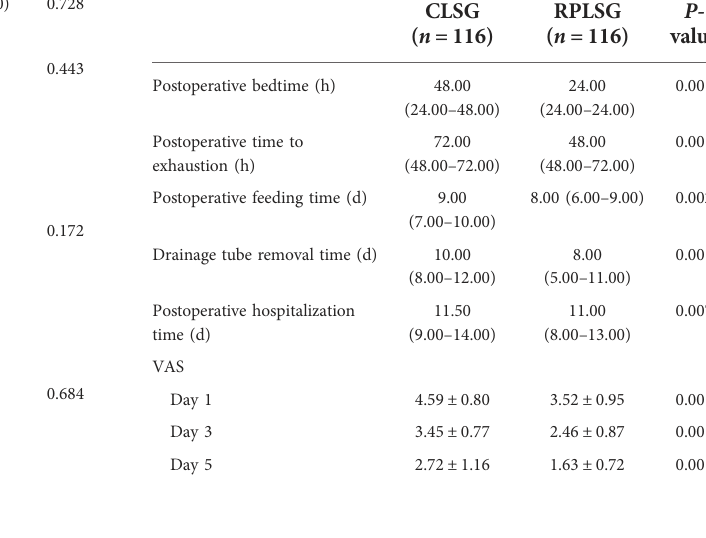
TABLE 4 Postoperative recovery